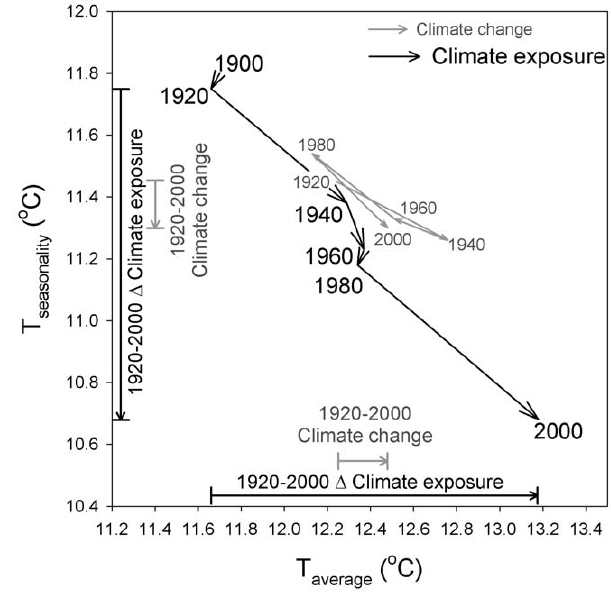
Figure 4. Changes in U.S. climate conditions averaged across 2728 counties ( Climate change ) and averaged across U.S. citizens ( Climate exposure ). The x-axis represents average annual temperature ( u C) and the y-axis temperature seasonality ( u C). The arrows beside the axes represent the change in climate conditions between 1920 and 2000 for both time series. We estimated the climate conditions of each temporal horizon by averaging annual climate conditions of the preceding 20 years and, given the lack of climate data prior to 1900, we used the 1901–1920 climate averages in our analyses of both 1900 and 1920. The Climate change result for 1900 is therefore omitted while the Climate exposure results in 1900 and 1920 are based on the same climate conditions but different population sizes. See Fig. S5 for a similar analysis based on precipitation.